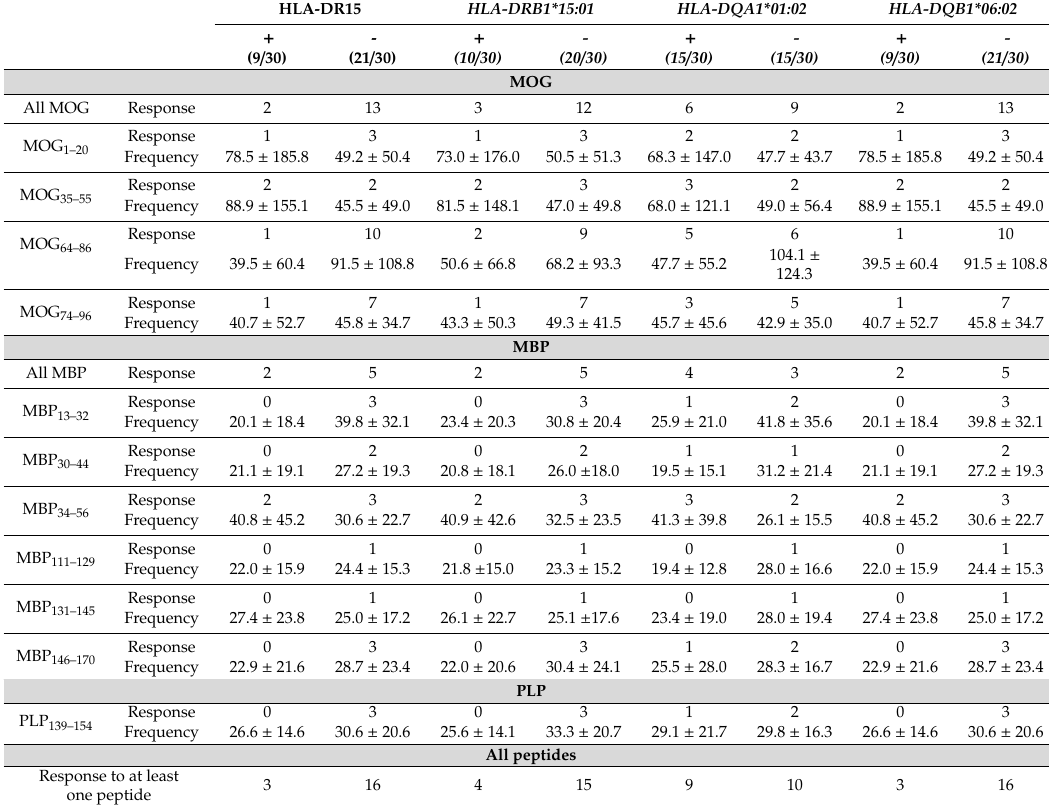
Table 4. Overview of the myelin peptide-specific T cell responses among carriers and non-carriers of MS-associated HLA susceptibility